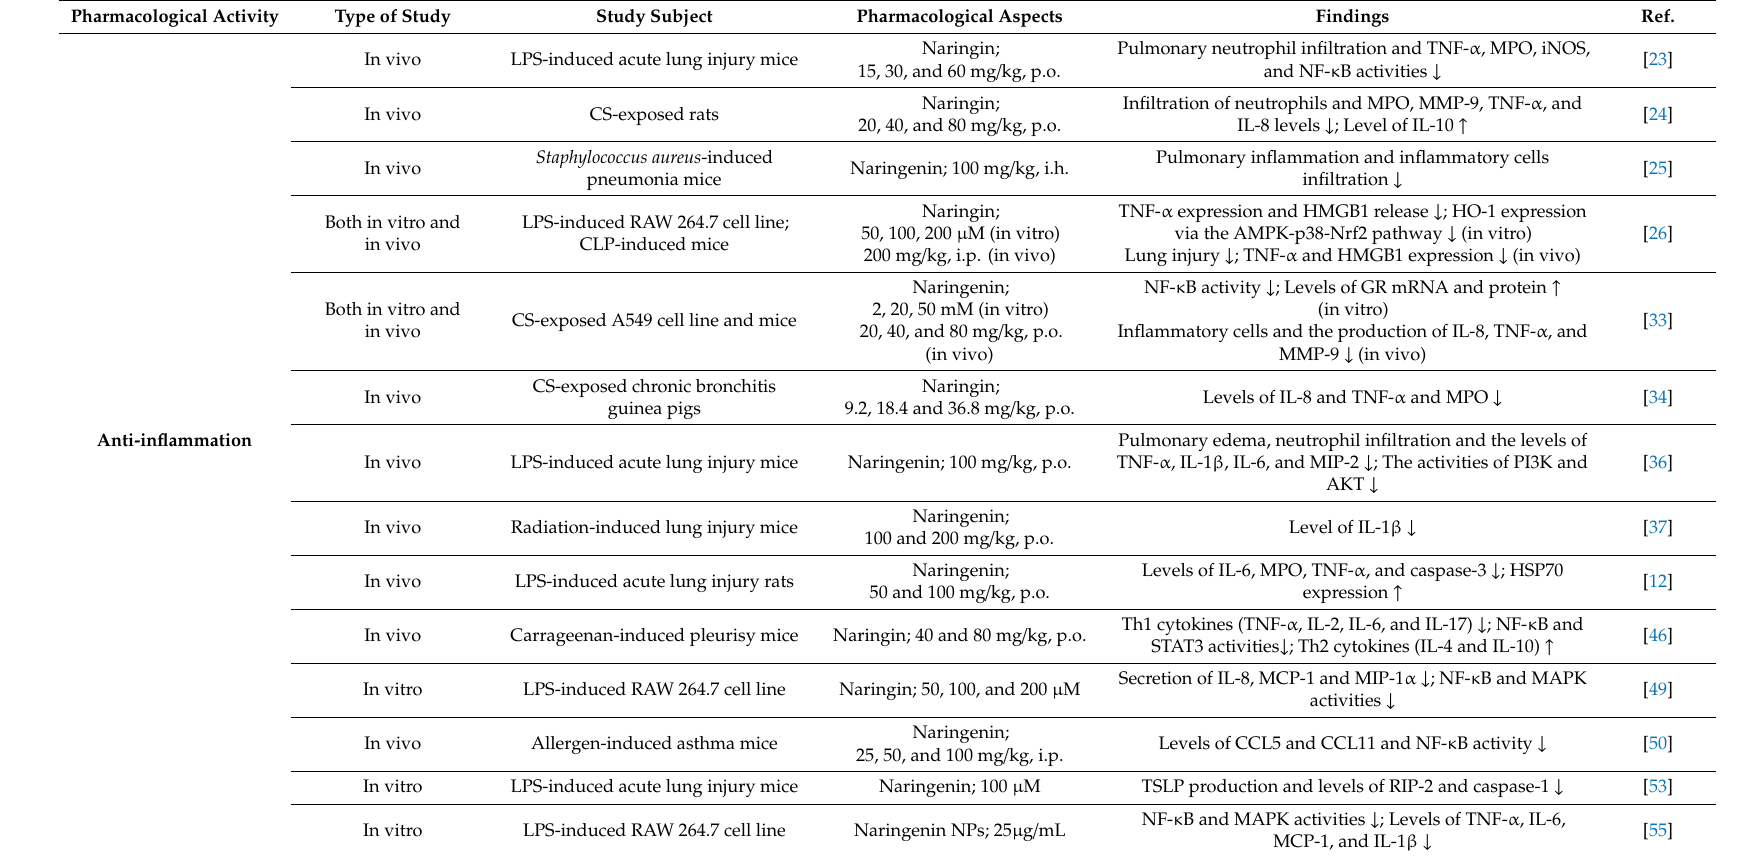
Table 1. Summary of anti-inflammatory activities of naringenin and